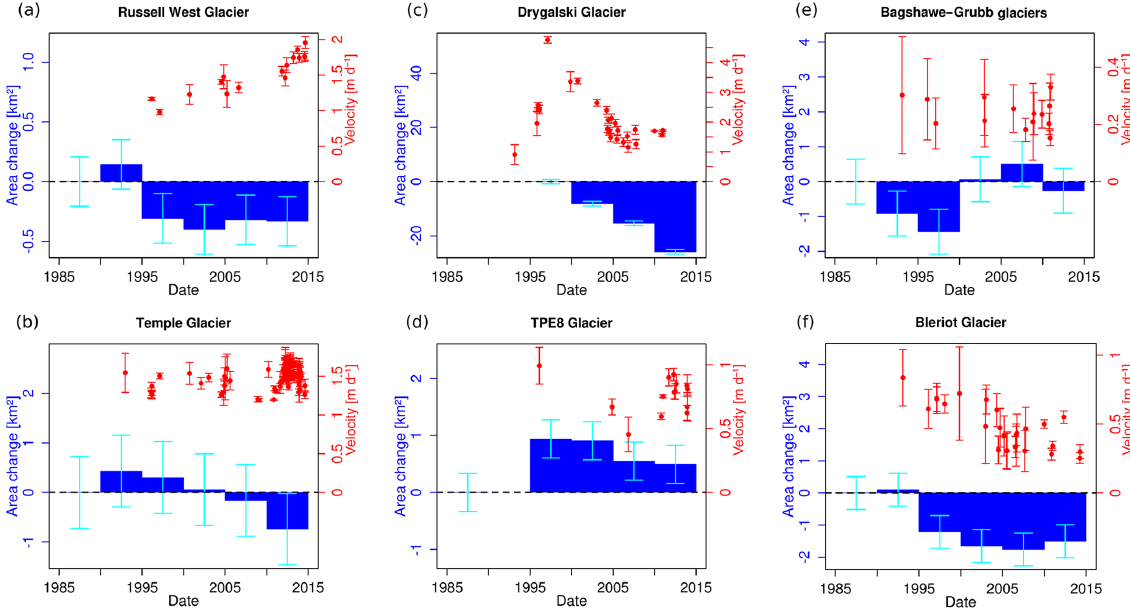
Figure 2. Temporal evolution of surface velocity (red, using first measuring approach) and area (blue) changes of selected glaciers in the study area for each velocity change category (see Table 3).